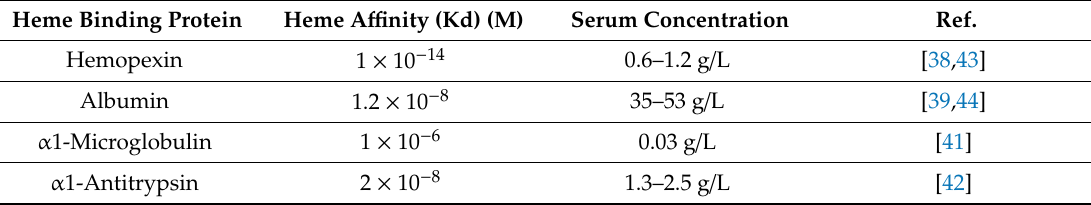
Table 1. Extracellular heme binding proteins in